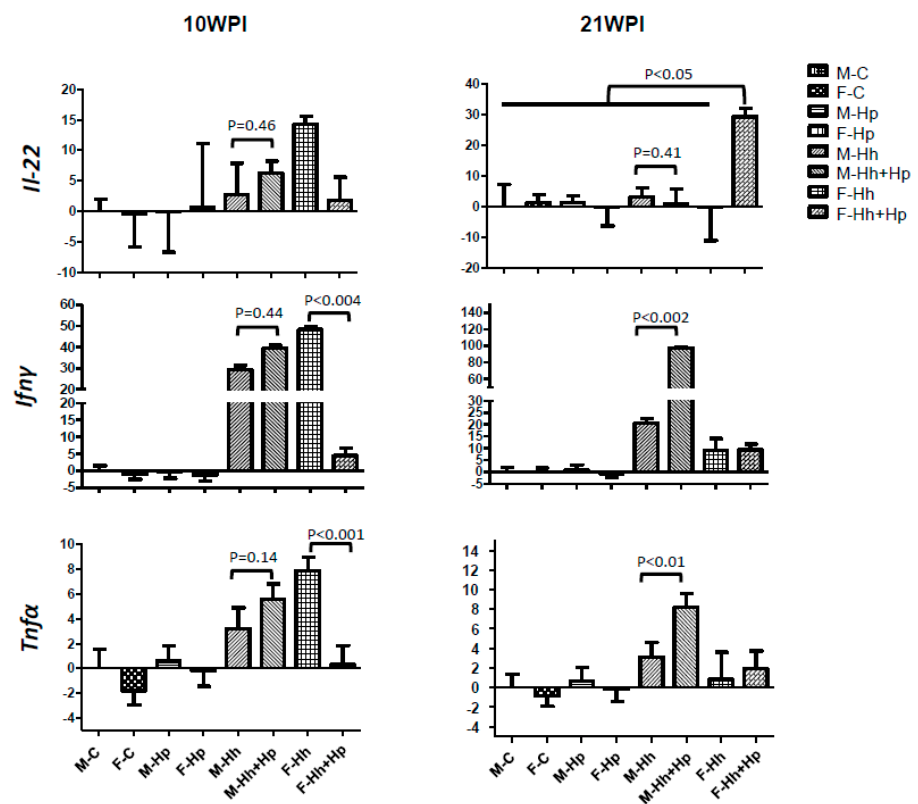
Figure 4. Co-infection with Hp in males increased mRNA levels of colonic ILC1s- and ILC3-associated cytokines compared to mono-Hh males at 21 WPI. Total RNA prepared from colonic tissues of mice infected or sham-dosed were evaluated by qPCR for expression levels of mRNA for select cytokines, which then were normalized to the expression of the house-keeping gene Gapdh . The Y axis represents the mean fold change (±standard deviation) of the mRNA levels in reference to uninfected male controls. 2.3. Colonization Levels of Gastric Hp and Intestinal Hh Were Minimally Influenced by Co-Infection or Sex Colonization levels of gastric Hp or intestinal Hh were determined by qPCR. Average levels of Hp in stomach were approximately 1 × 10 5 per µ g mouse DNA (Figure 5). There was no statistical di ff erence in gastric Hp levels between Hh + Hp and mono-Hp groups or sexes in the same group at both time-points. Average colonization levels of cecal Hh were ~10 7 organisms per µ g mouse DNA, which is about 10-fold higher compared to those in the colon. There was no statistical significance in cecal Hh levels between mono-Hh infected and Hh + Hp mice or sexes at 10 WPI. At 21 WPI, co-infected females had higher cecal Hh levels compared to mono-Hh females (Figure 5, p = 0.001). There was no statistical significance in Hh colonization levels between the sexes or infection status at either time point in the